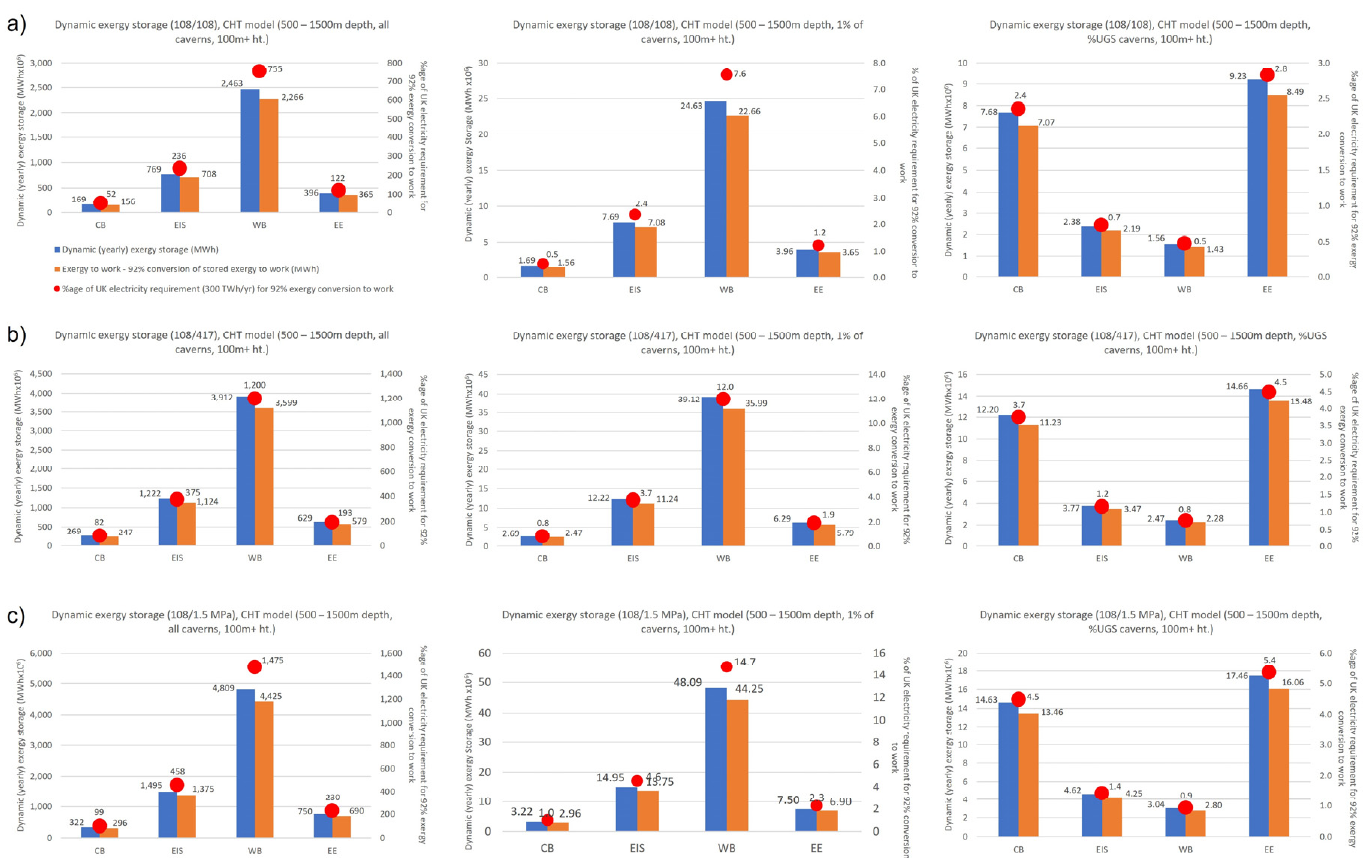
6 Figure 6. Plots of dynamic exergy storage and exergy to work estimates for the preferred CHT model over the depth range 500–1500 m and cavern heights 100 m+ considered for CAES. Parts ( a – c ) show graphs for differing injection/withdrawal rates (108/108 kg/s and 108/417 kg/s) or fill and pressure reduction rates (108 kg/s/1.5 MPa/h) for all potentially available caverns, 1% of available caverns, and estimates based upon the number of UGS caverns in the basins. Additionally shown, by basin, the percentage of UK electricity demand for 92% of stored exergy to work. Key common to all, see Figure